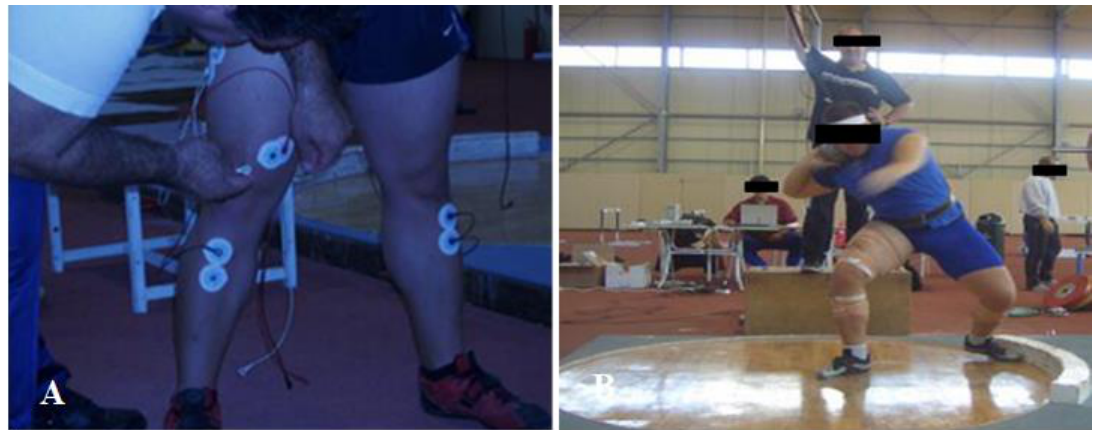
Figure 1. Electromyographic measurement of shot-put throw in well-trained shot putters using the rotational technique. ( A ) The placement of EMG on quadriceps muscles and ( B ) the measurement of shot-put throw with the rotational technique [18].